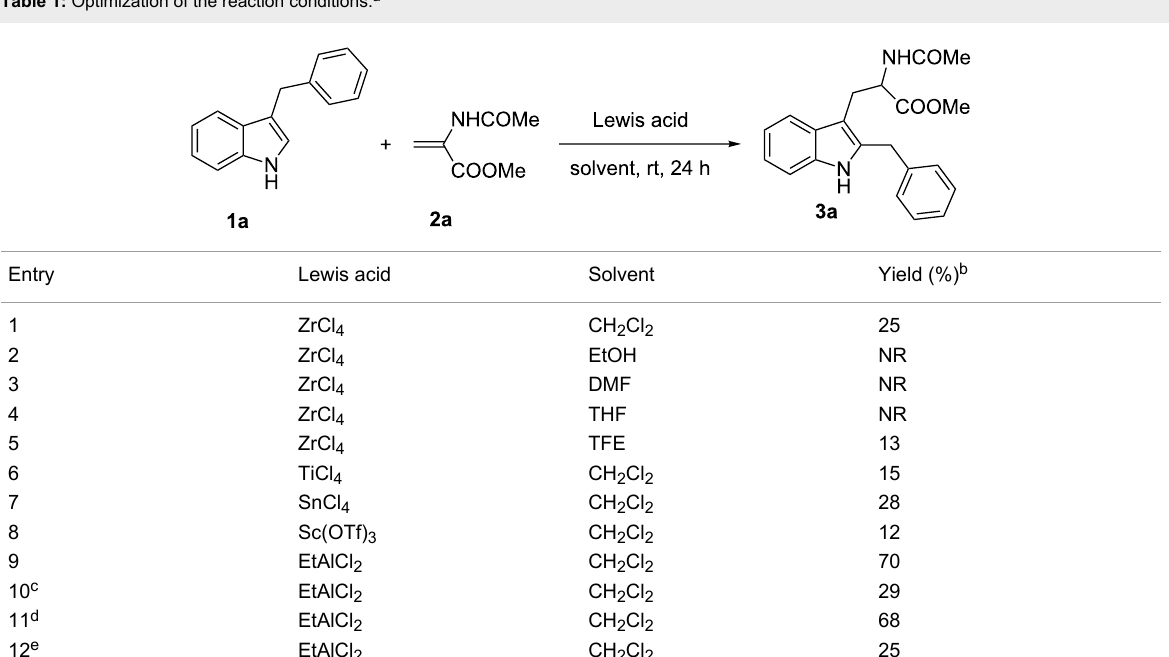
Table 1: Optimization of the reaction conditions. a